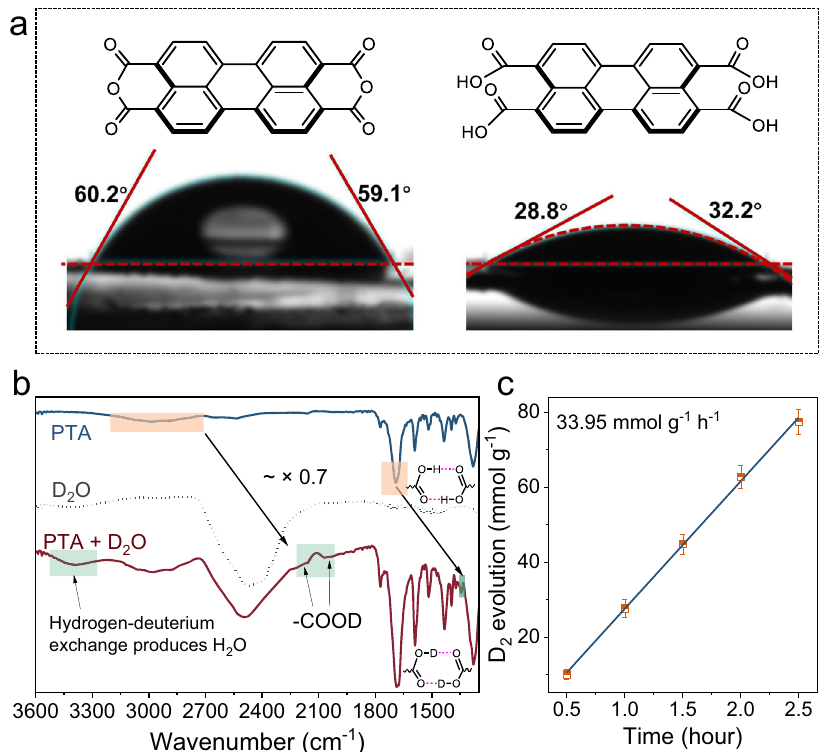
Fig. 6 Hydrophilic sites for hydrogen evolution. a Contact angle of PTCDA and PTA with water. b ATR-FTIR spectra of PTA before and after in situ adsorption of D 2 O. c D 2 evolution performance of PTA-split D 2 O.